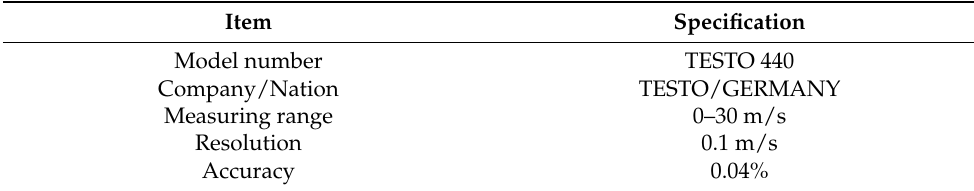
Figure 1. Terminal velocity experiment bench ( a ) and wind velocity measuring instrument ( b ). Table 1. Specifications of wind velocity measuring